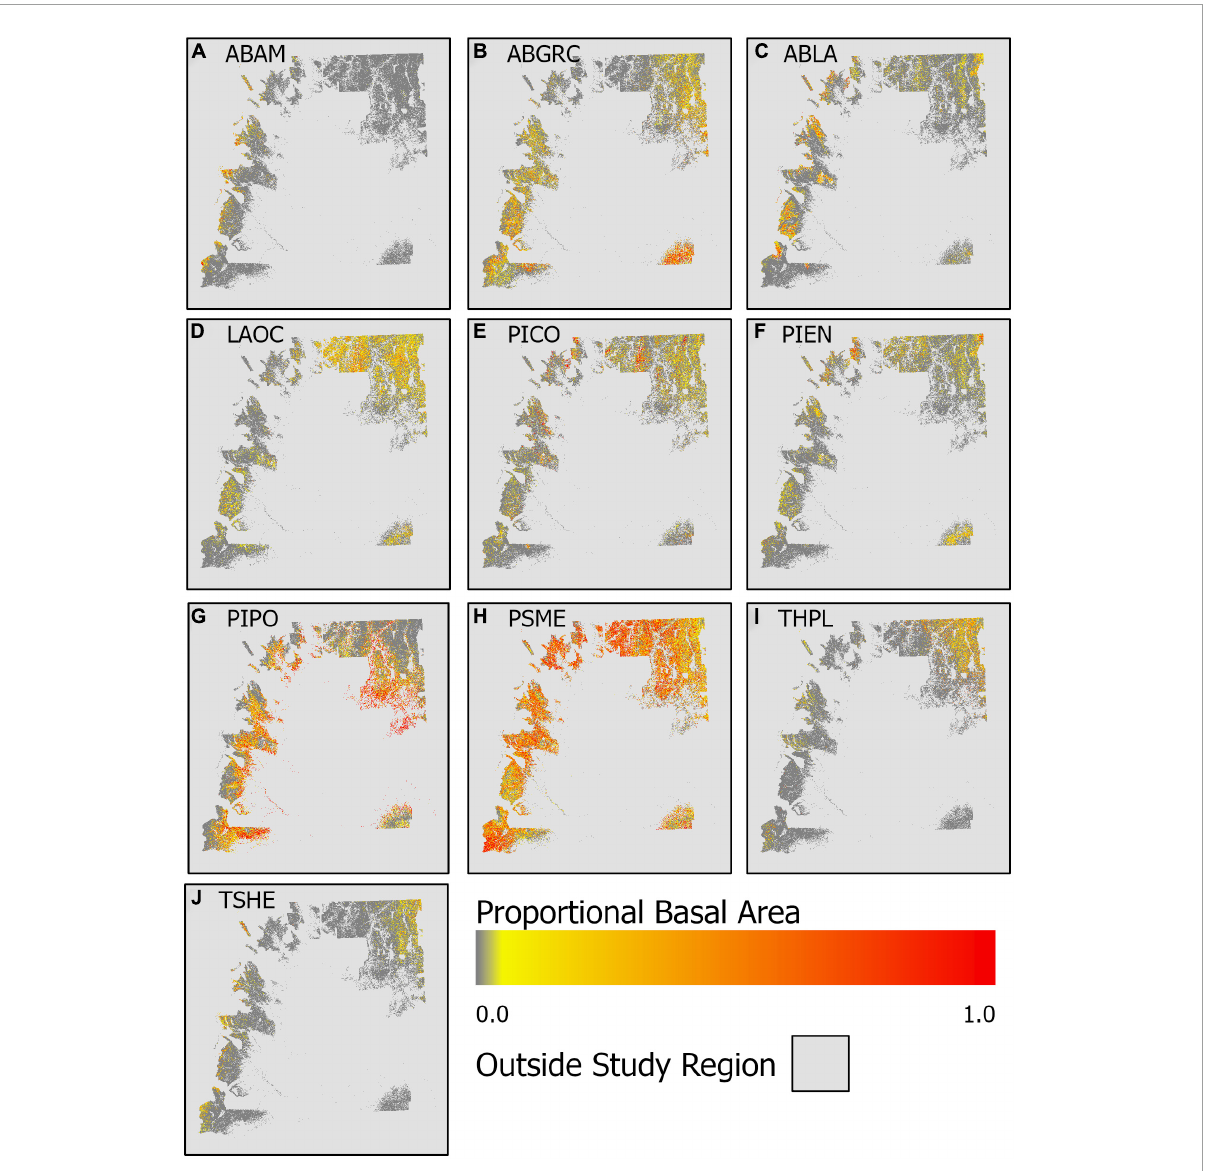
FIGURE5 Spatial patterns of predicted proportional basal area for the 10 species: (A) A. amabilis (ABAM), (B) A. grandis and A. concolor (ABGRC), (C) A. lasciocarpa (ABLA), (D) L. occidentalis (LAOC), (E) P. contorta (PICO), (F) P. engemannii (PIEN), (G) P. ponderosa (PIPO), (H) P. mensiesii (PSME), (I) T. plicata (THPL), and (J) , T. heterophylla